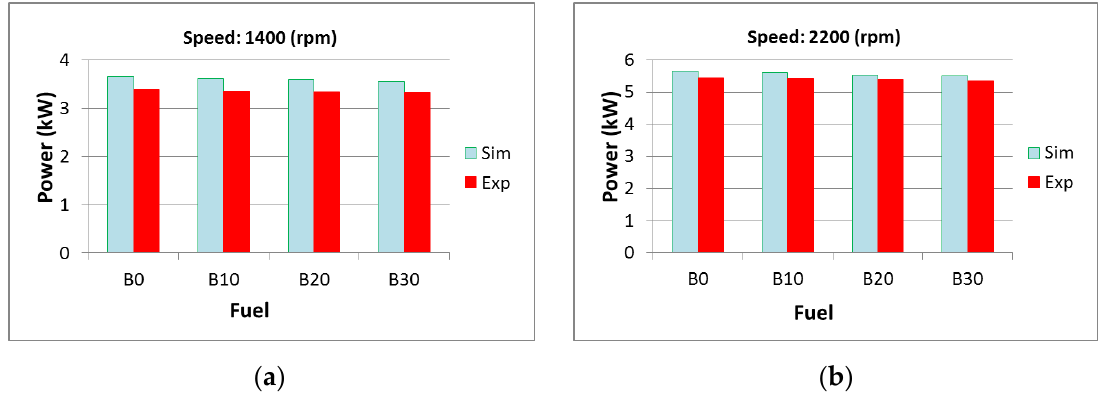
Figure 4. Comparisons between simulation results and experimental of power. ( a ) Speed at 1400 (rpm); ( b ) Speed at 2200 (rpm).